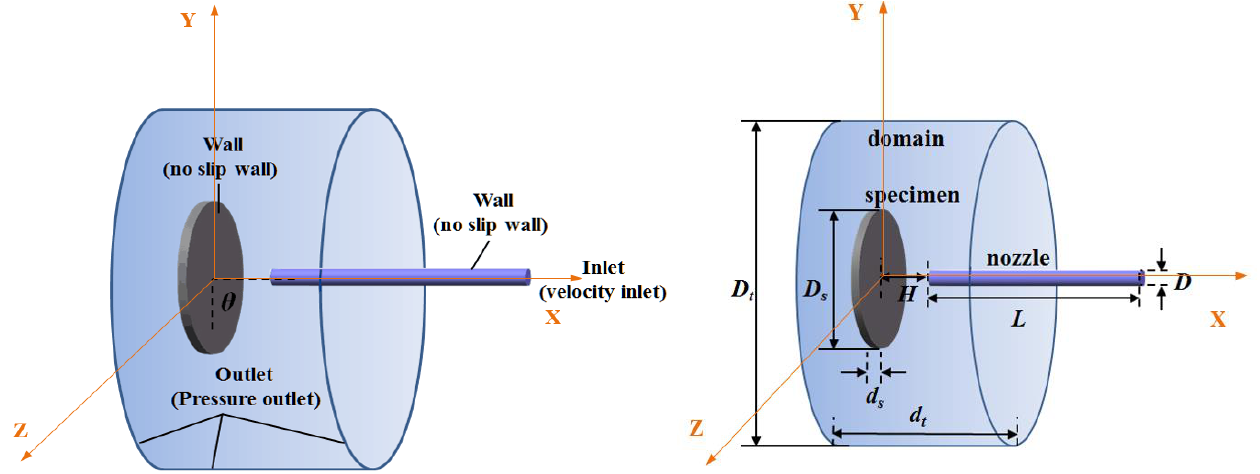
Figure 6. Numerical model and boundary condition diagram of the gas-solid two-phase flow impact specimen test.